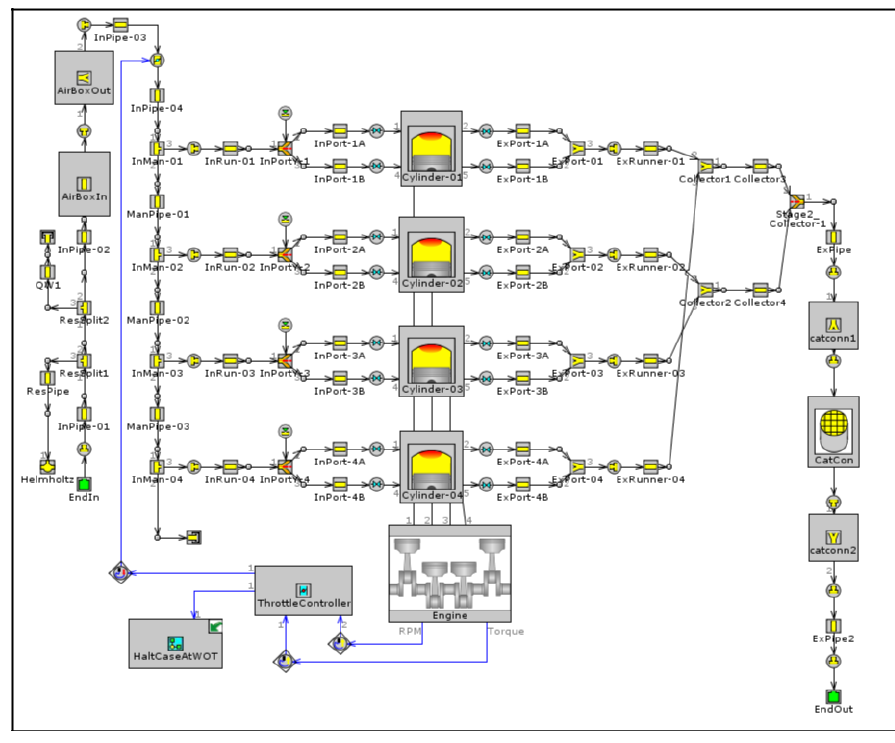
Figure 1. 4-Cylinder Engine. Table 1. Engine specifications.